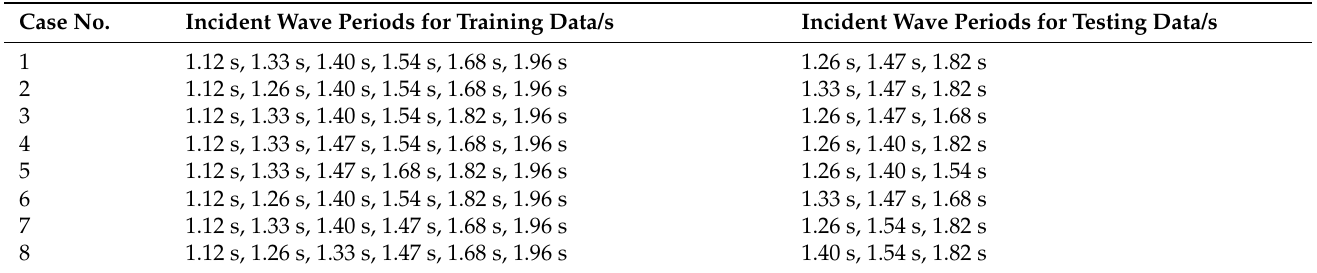
Table 4. Arrangement of training and testing data (6 training data